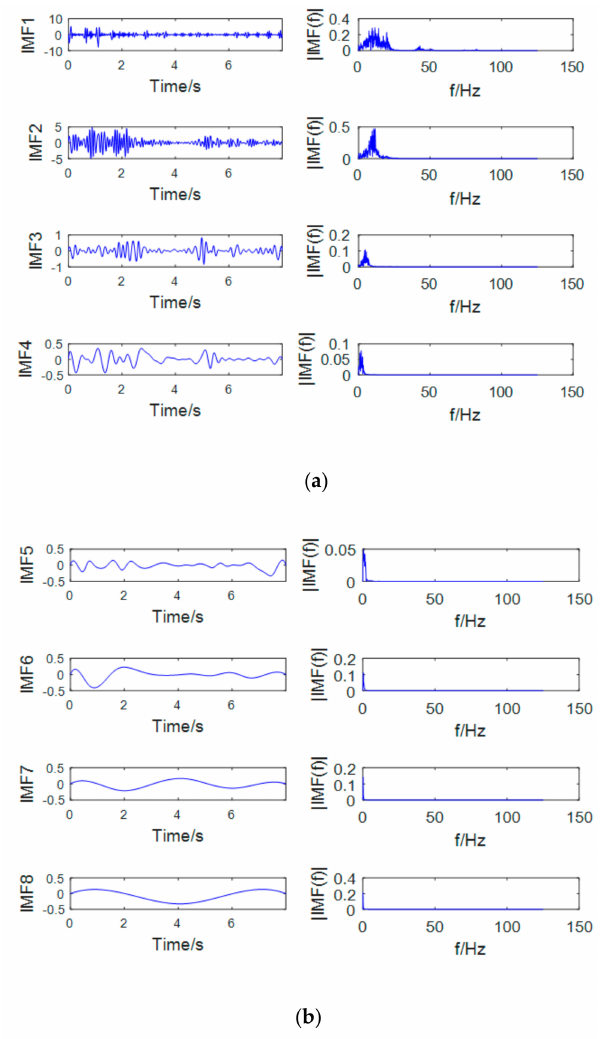
Figure 8. Sub-band D4 EMD graph (left—waveform; right—spectrum): ( a ) IMFs and corresponding spectrum of orders of 1-4 by EMD method; ( b ) IMFs and corresponding spectrum of orders of 5-8 by EMD